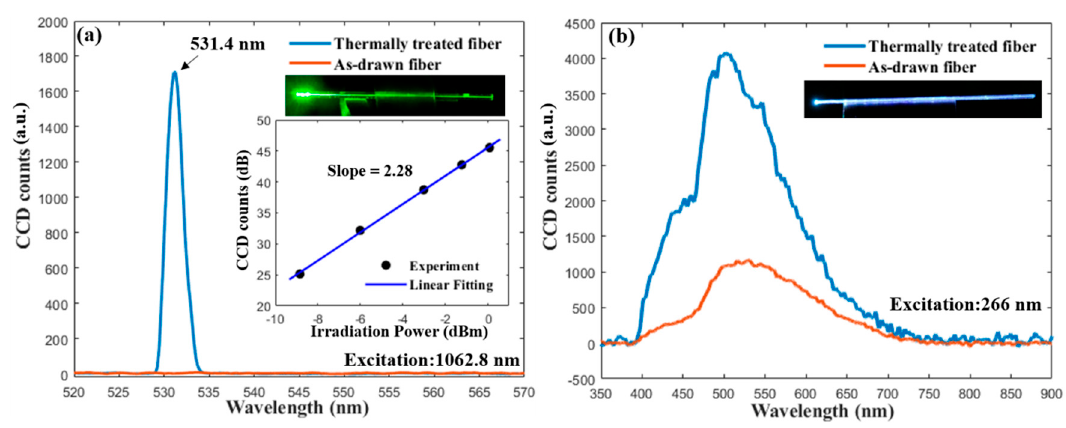
Figure 5. ( a ) The emission spectra of the as-drawn and thermally heat-treated fiber excited by a 1064 nm picosecond laser. The inserts show an image of the emission taken by a DSLR camera and the relation between the emission intensity and irradiation power in double-logarithmic scale; ( b ) the photoluminescence spectra of the as-drawn and thermally heat-treated fiber excited by a 266 nm laser.